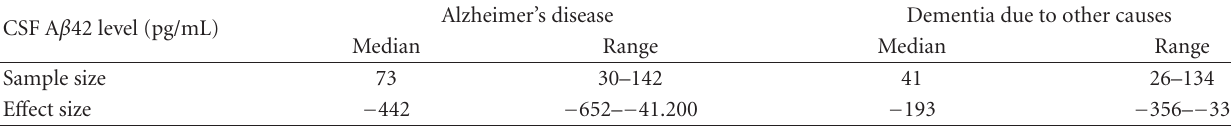
Table 5: Descriptive statistics of CSF A β 42 studies in Alzheimer’s disease and dementia due to other causes.